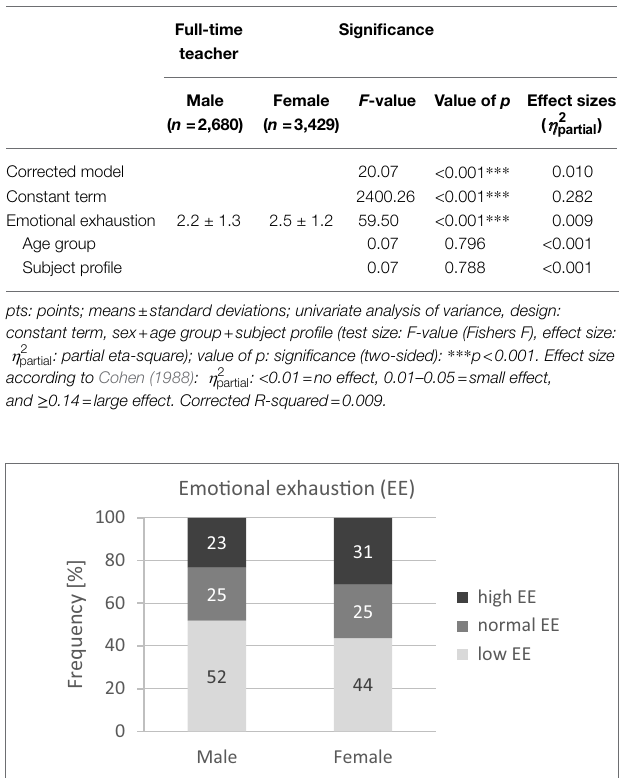
TABLE 4 | Main effects of emotional exhaustion and covariates (age groups and subject profile) of male and female full-time teachers.